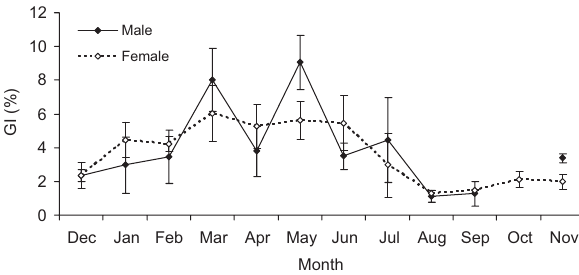
Figure 2. Monthly variation of the gonad index (GI) of males and females of Echinaster ( Othilia ) guyanensis collected in southeastern Brazil (Dec., Jan., Fev., Mar., Apr., Jun., Ago., Sept. n = 5 females and 5 males; May., Jul., n = 6 females and 4 males; Oct. n = 10 females; Nov. n = 4 females and 6 males).